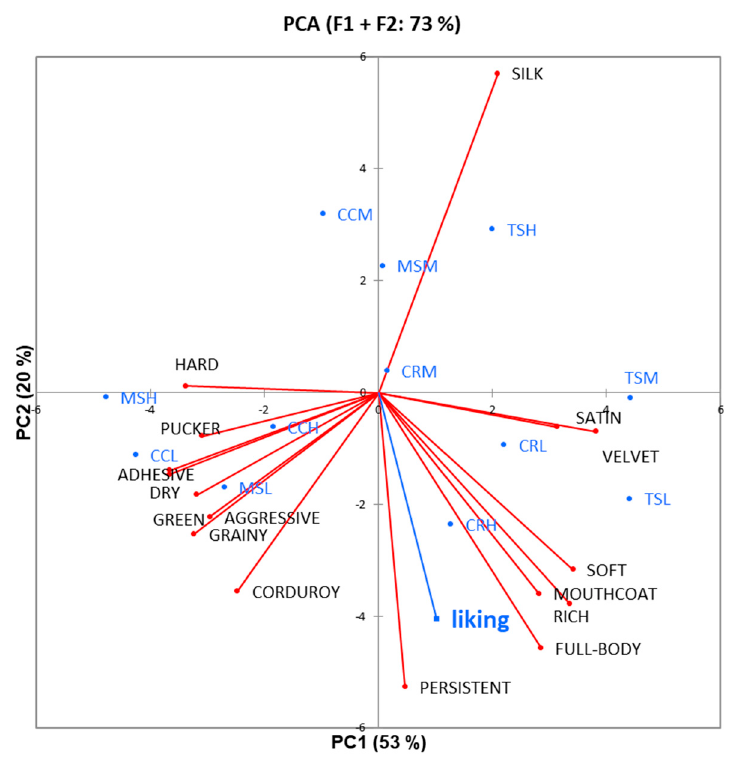
Figure 4. Multivariate data analysis (PCA) on the liking scores from consumers as a supplementary variable and intensity of astringency subqualities (RATA) by trained assessors for Sangiovese wines (MS: Morellino di Scansano; TS: Toscana; CC: Chianti Classico; CR: Chianti Riserva) belonging to